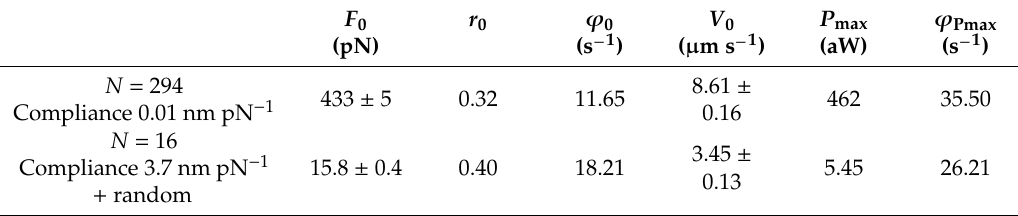
Table 1. Simulated mechanical and energetic parameters of the muscle half-sarcomere and of the nanomachine. The parameters reported in the table are defined below and are accompanied by the references that provide the standard values used to constrain the simulation at the level of the muscle half-sarcomere. Data in the first line, concerning the whole muscle, are reported from Table 1 in [10]. N , number of available motors, which, per half-thick filament, are (49 crowns times 6 motors per crown = ) 294 [29]; F 0 , isometric force referring to the half-thick filament [16]; r 0 , isometric duty ratio [33]; ϕ 0 , flux through step 1 of the cycle in Figure 3a in isometric conditions, corresponding to the ATP hydrolysis rate per myosin head at F 0 , [19] and references therein; V 0 , maximum